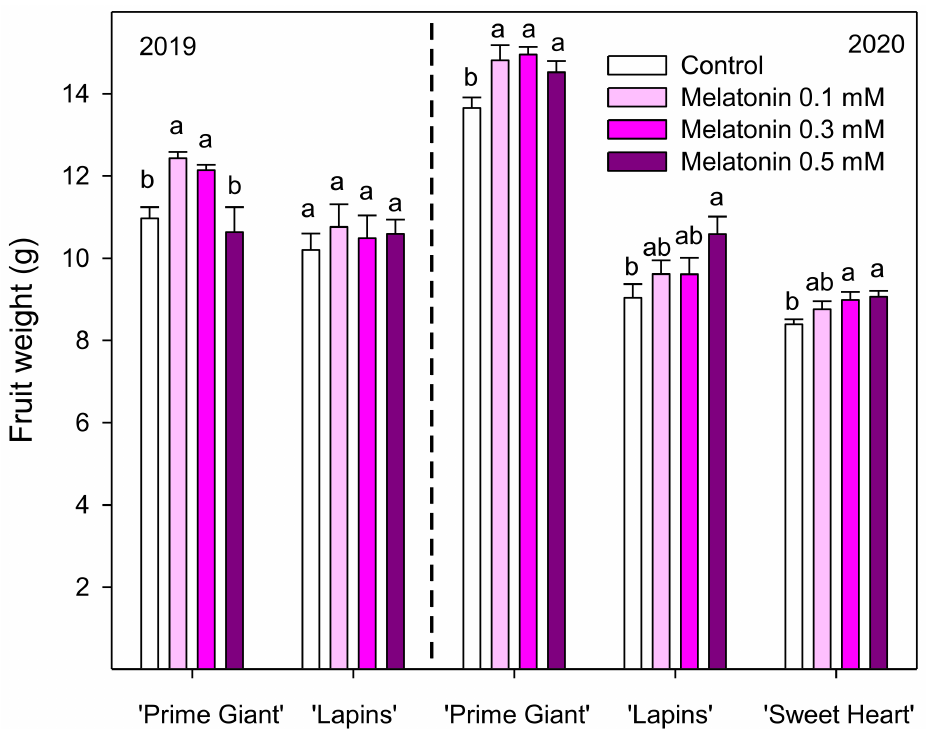
Figure 3. Effects of sweet cherry trees’ melatonin treatments on fruit weight (g) in the 2019 and 2020 experiments. Data are the mean ± SE of 100 fruit taken at random from commercial fruit of control or treated trees. Different letters show significant differences ( p < 0.05) between treatments for each cultivar and